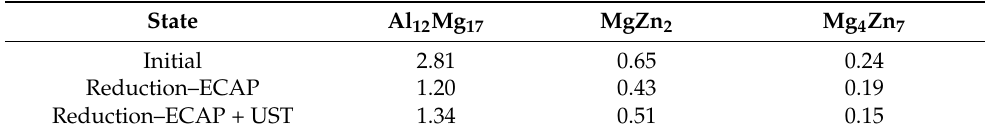
Table 2. Changes in the volumetric share (%) of second phases during reduction – ECAP and UST.